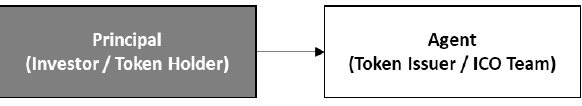
Figure 1. Principal and Agent in the context of for-business